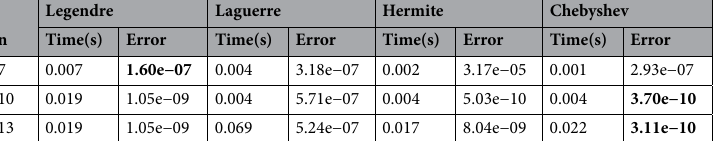
Table 13. Comparision of maximum relative error of z 2 ( t ) for Example 7.3 with different numbers of neurons. Significant values are in bold.